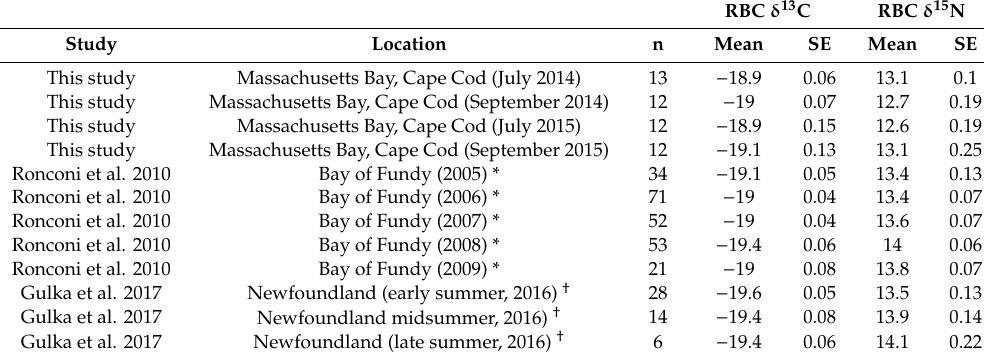
Table 1. A comparison of the δ 13 C and δ 15 N of the RBCs (cellular portion of blood) and feathers of great shearwaters caught in the North Atlantic. Standard errors (SE) are given for RBCs, while standard deviations (SD) are given for feathers in order to be consistent with values previously